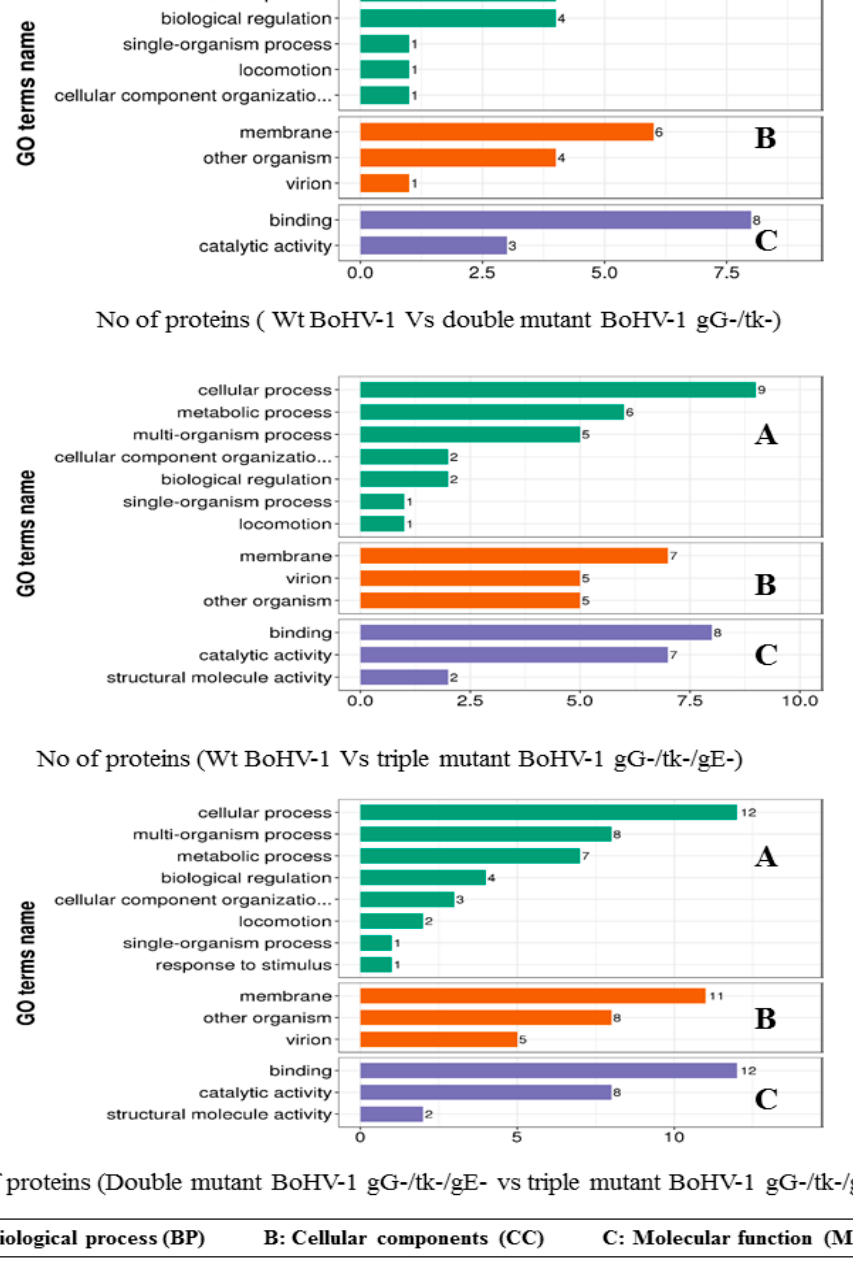
Figure 3. Biological process, cellular components, and molecular function categories of proteomic data by bioinformatic analysis of different comparable groups based on information provided by the online resource Gene Ontology, UniProt-GOA database and the InterProScan software. ( A ) Biological process. ( B ) Cellular components. ( C ) Molecular function.